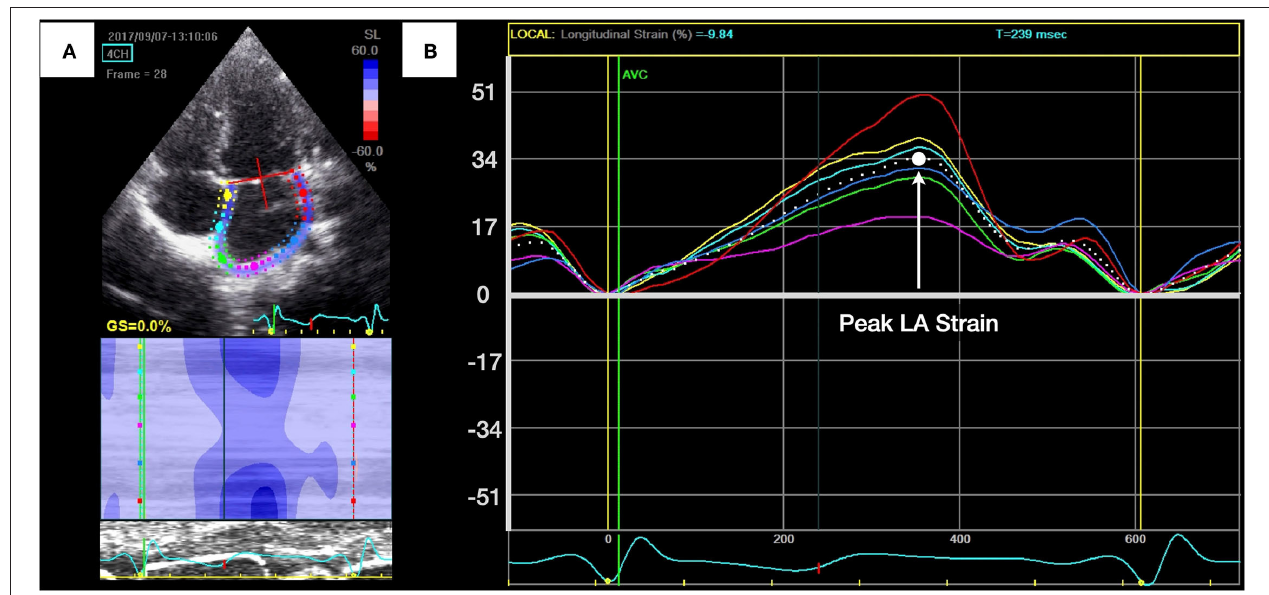
FIGURE 2 | Measurement of left atrial (LA) longitudinal peak systolic strain. (A) Apical four-chamber view of the left atrium with the region of interest. (B) The peak LA longitudinal strain during reservoir phase was identified as the highest point and was calculated by averaging measurements of six curves.